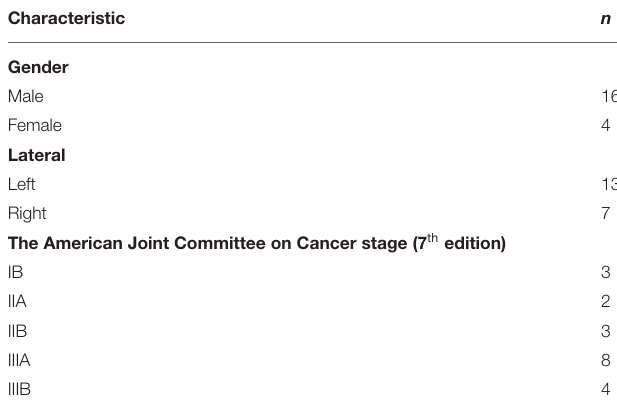
FIGURE 3 | Explanation of how to obtain the ray projection isocentric plane. S is an isocenter plane, and S is parallel to the plane in which the coordinate system X and Y axis are located. Each point on S (i.e., the intersection of the ray R and the isocenter plane S) represents a ray. The intensity of each ray is I, and there is a 2-D ray intensity distribution I (x, y) on the isocenter plane.